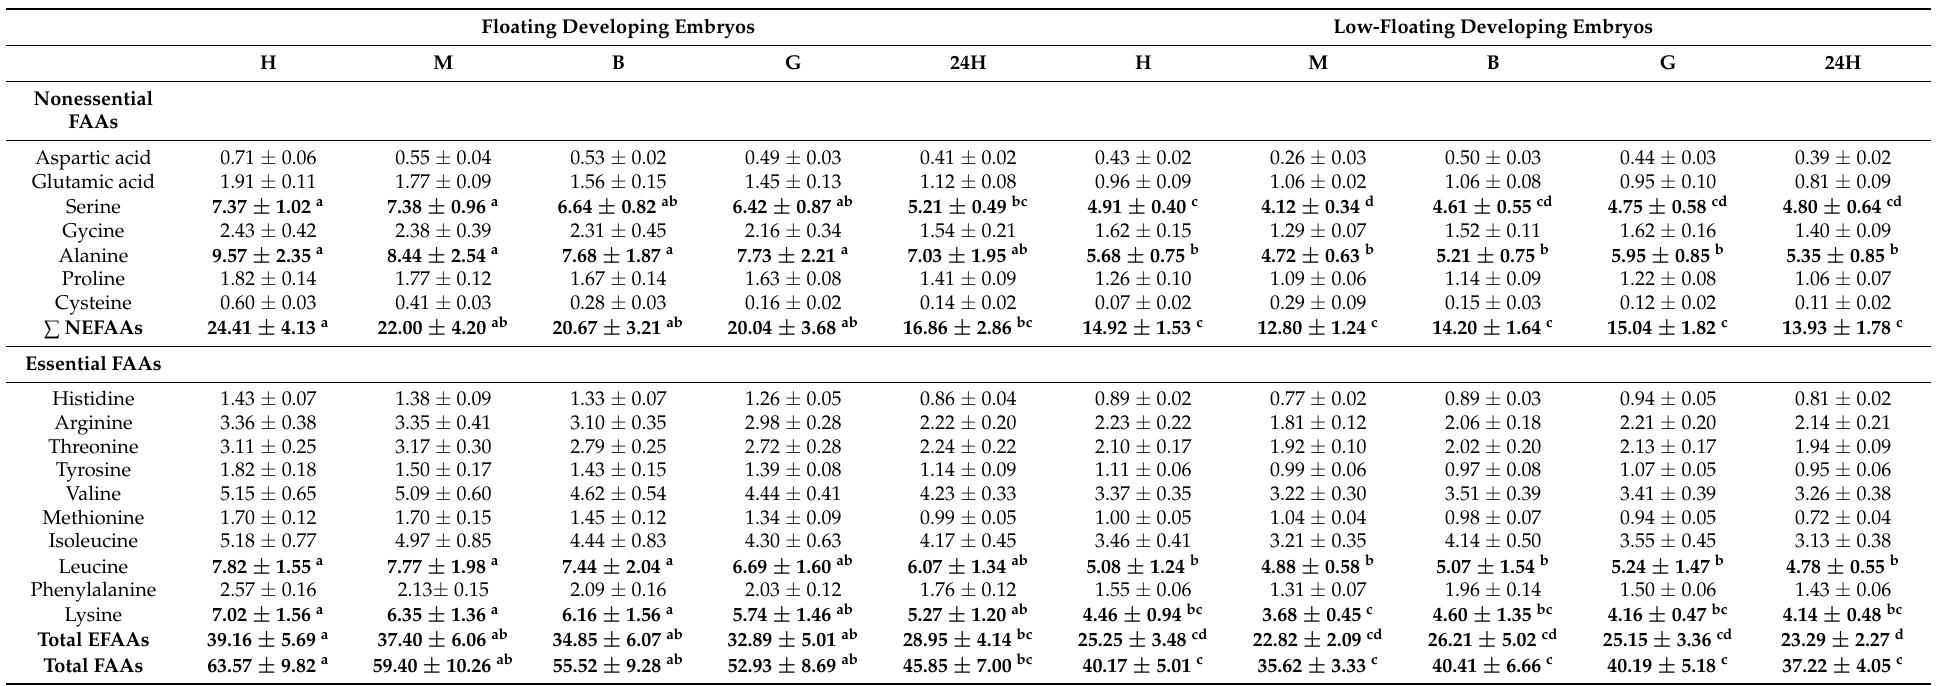
Table 2. Qualitative and quantitative profile of FAAs in floating and low-floating Seriola lalandi developing embryos. Fertilized eggs, morula, blastula and 24 h post-fertilization embryos are identified as E, M, B, G and 24H, respectively. Value represents the FAA amount (nanomoles of FAAs/mg wet weight) ± standard deviation (SD) of six replicates, and the different letters in rows indicate significant differences ( p < 0.05) assessed using Tukey’s test. NEFAAs correspond to non-essential FAAs and EFAAs to essential